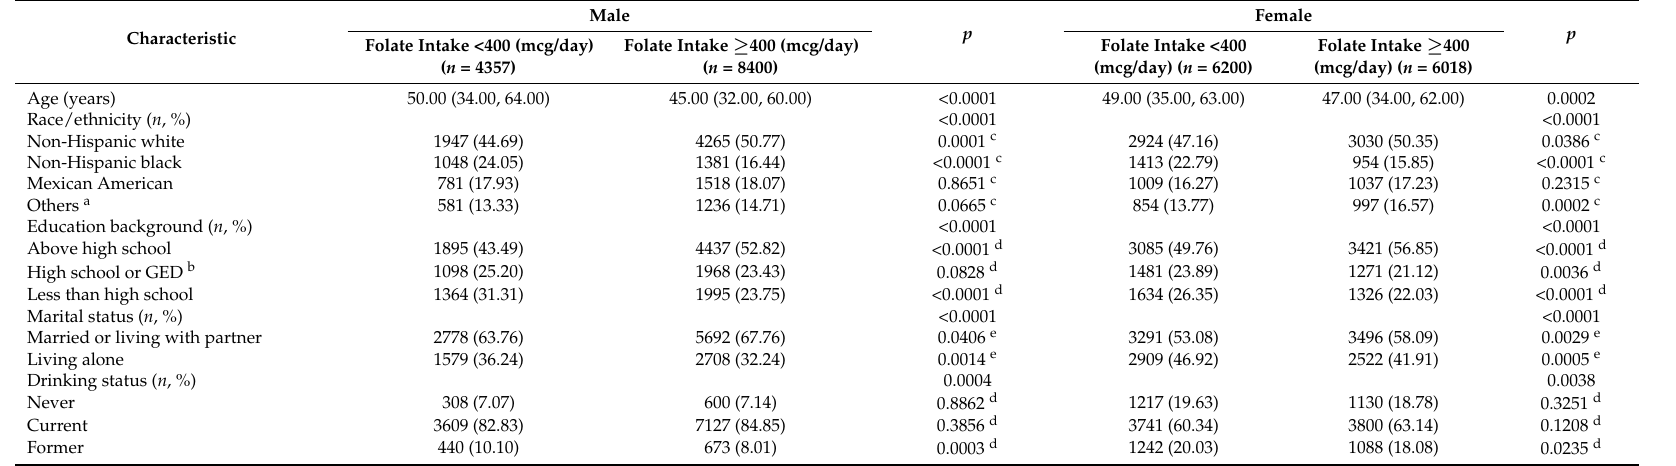
Table 2. Characteristics of the participants according to intake of folate